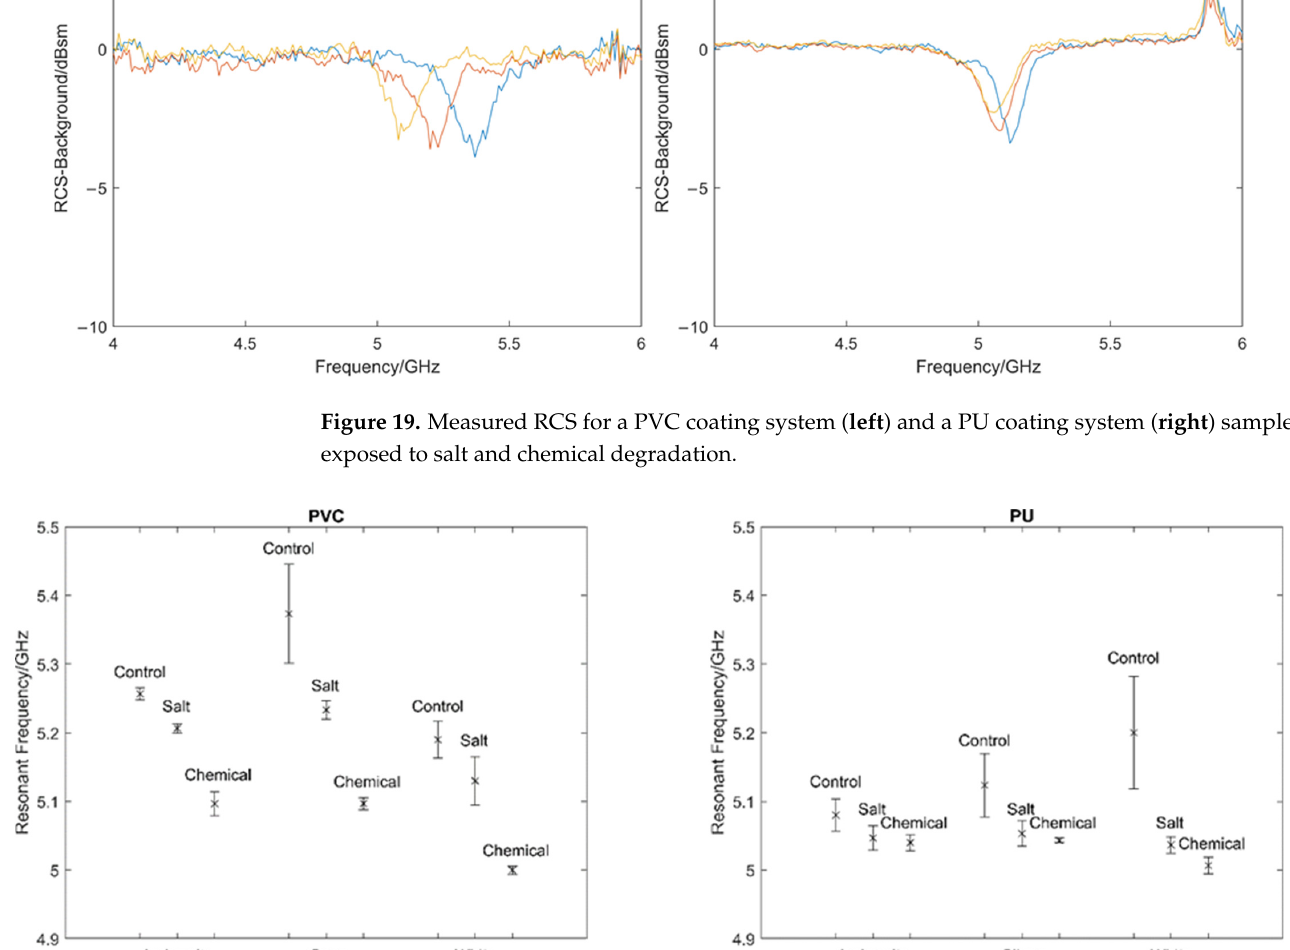
Figure 19. Measured RCS for a PVC coating system ( left ) and a PU coating system ( right ) samples exposed to salt and chemical degradation.